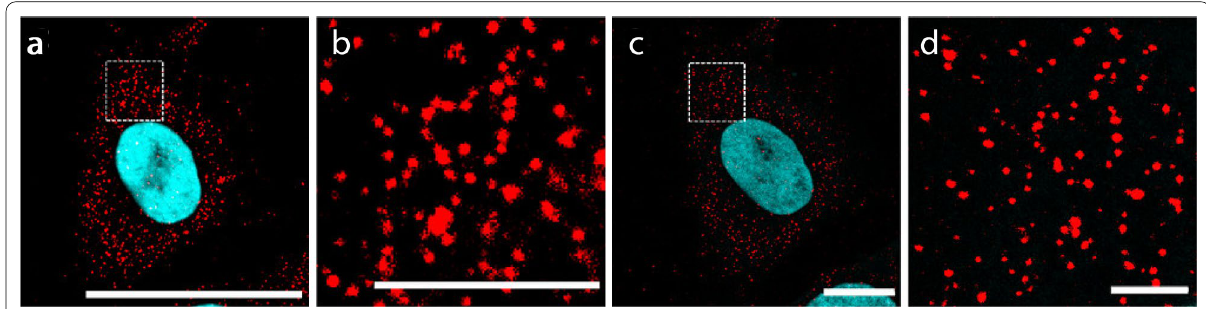
Fig. 10 RNA detection by combining ExM and hybridization chain reaction (HCR) v3.0 using a TRITON linker. a Pre-expansion image of PGK1 transcripts. b Magnified view of the boxed region in a . c Post-expansion image of the same cell. d Magnified view of the boxed region in c . Scale bars, 50 μm ( a , c ) and 10 μm ( b , d ). (Reprinted/adapted with the permission from Wen et al. [40]. Copyright 2021 American Chemical Society)